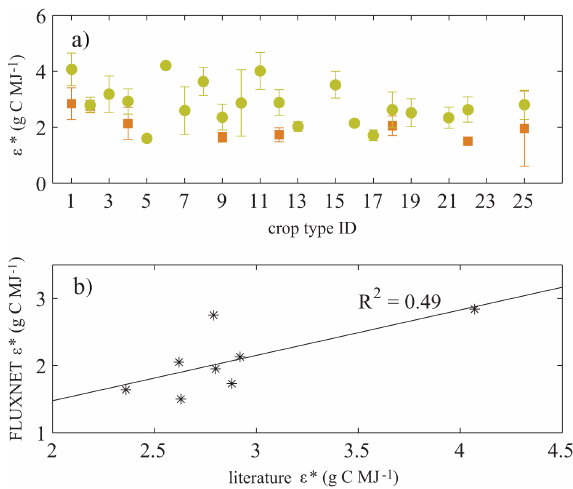
Figure 1. Maximum light use efficiency ( ε ∗ different crop types based on FLUXNET sites (orange) and litera- ture (green) with error bars representing two standard deviations of ε ∗ . The corresponding crop types are given in Table 2. (b) Linear GPP relation between FLUXNET-based and literature-based ε ∗ mations for the eight crop types listed in Table